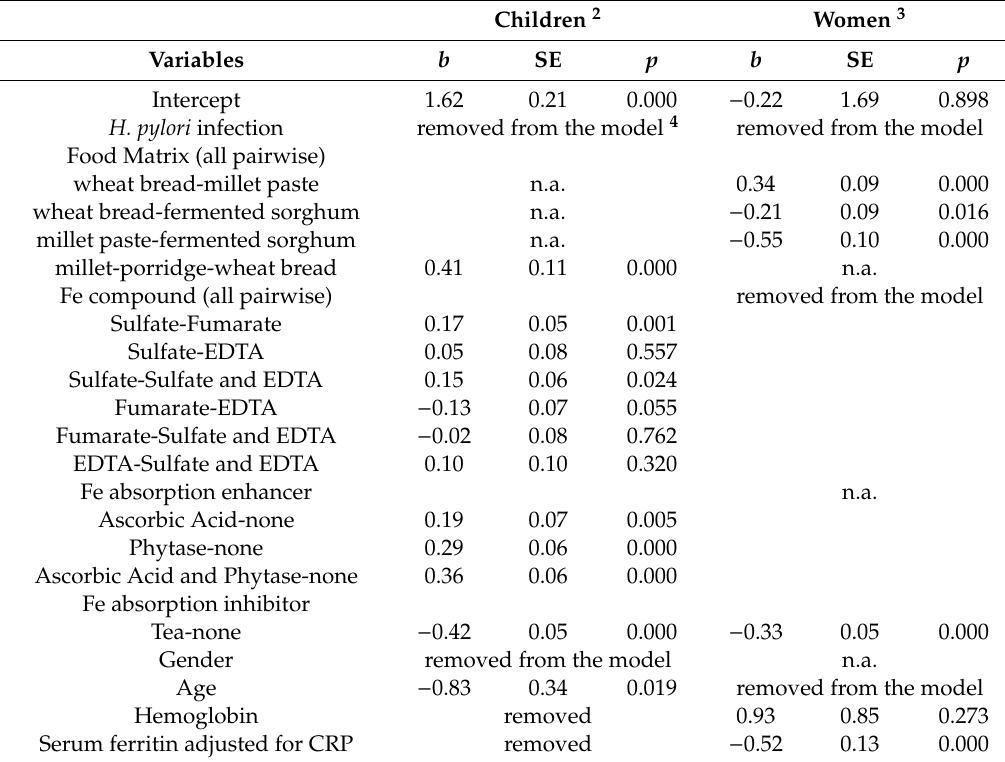
Table 3. The minimal adequate model predicting fractional iron absorption of preschool children ( n = 90) and women of reproductive age ( n = 80) in relation to H. pylroi infection, food matrix, iron compound, whether the test meal contained an iron absorption enhancer or inhibitor, gender, age, hemoglobin and serum ferritin adjusted for inflammation 1